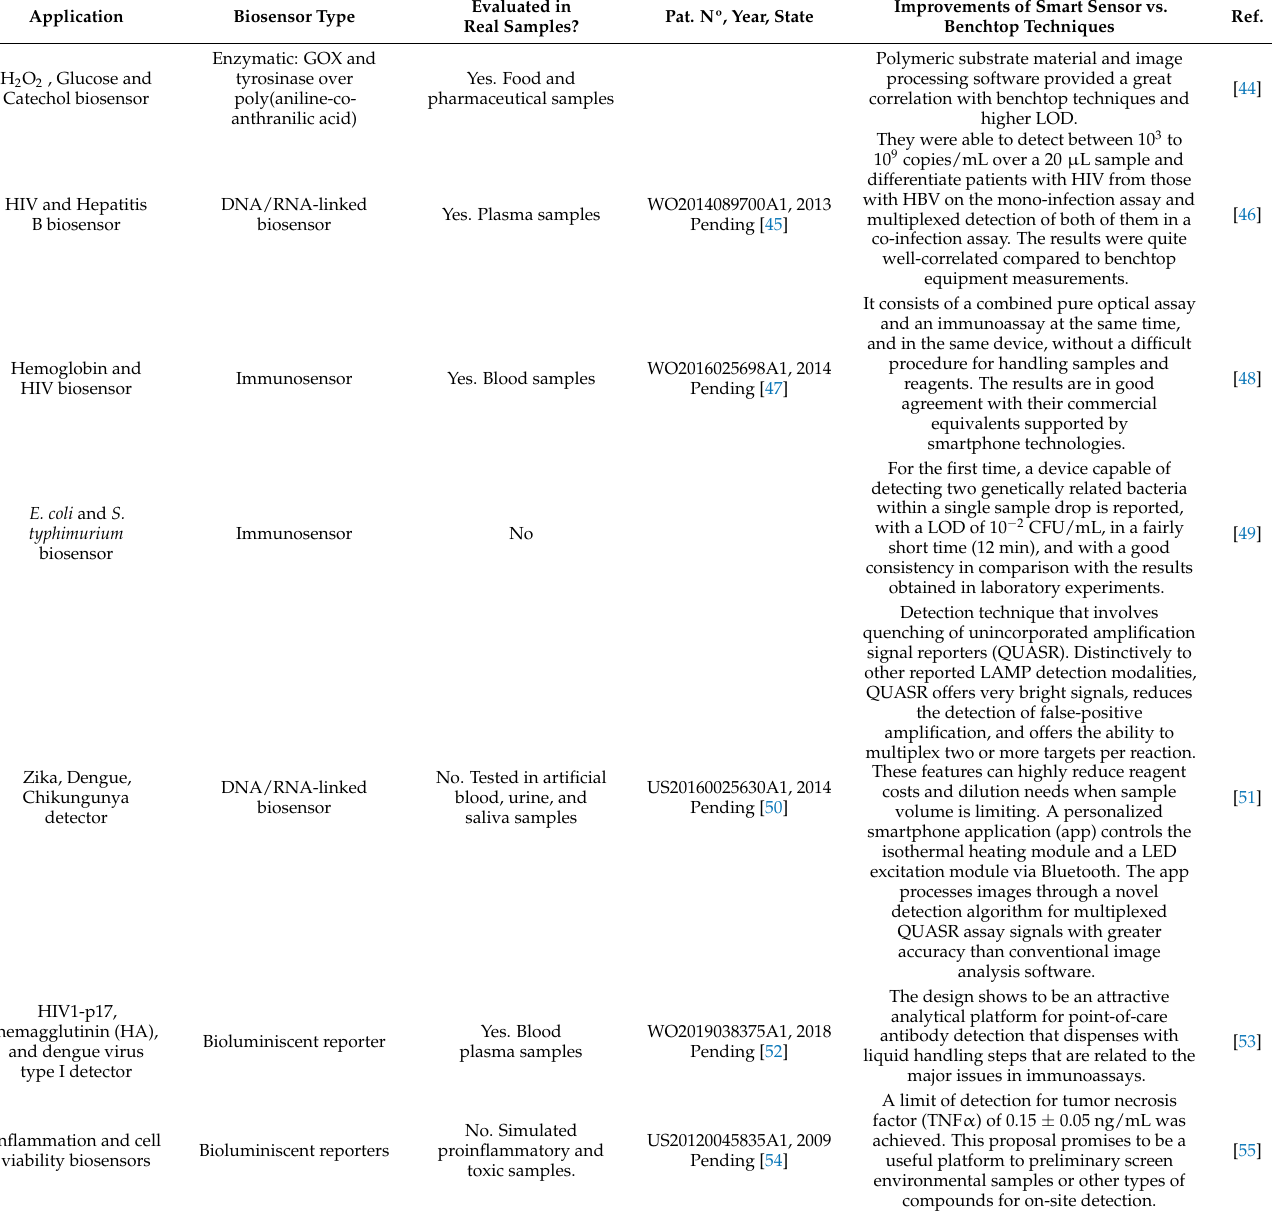
Table 2. Smartphone-based optical biosensors compared with benchtop